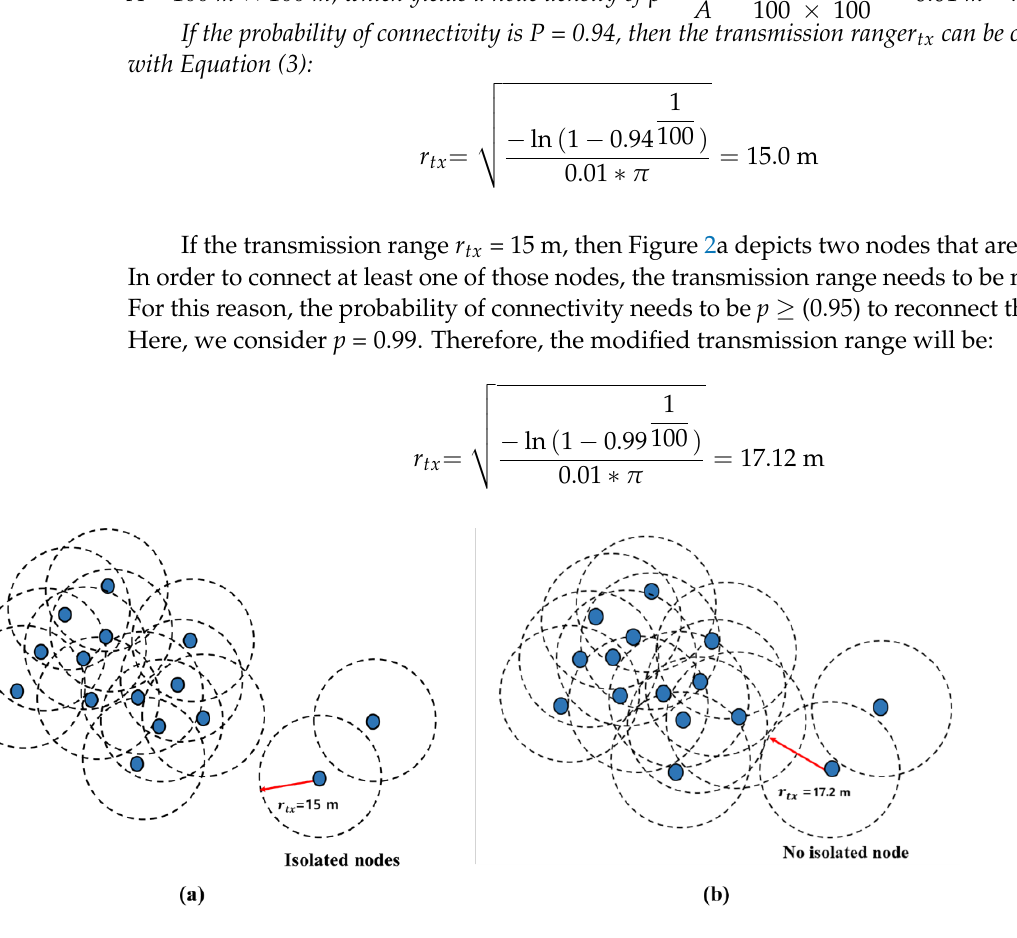
Figure 2. ( a ) Isolated nodes are found. ( b ) By increasing transmission range 𝑟 𝑡𝑥 , connections are established in the whole network, and no isolated nodes are observed.